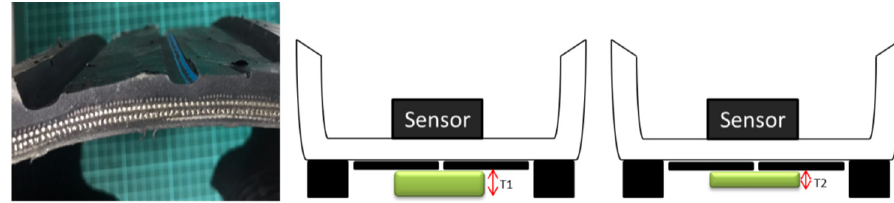
Figure 8. The magnetic field measurement.